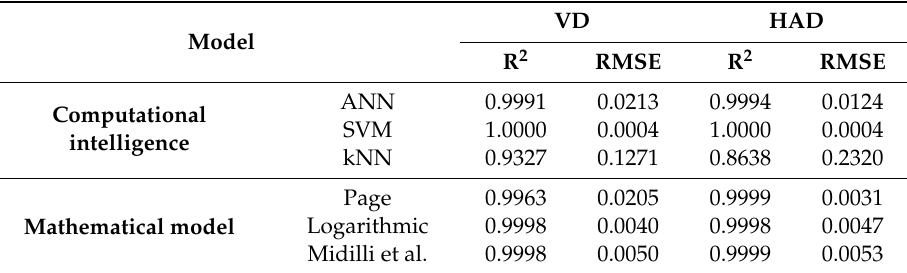
Table 14. Statistical results of drying kinetics of persimmon samples for computational intelligence and mathematical thin-layer models using VD and